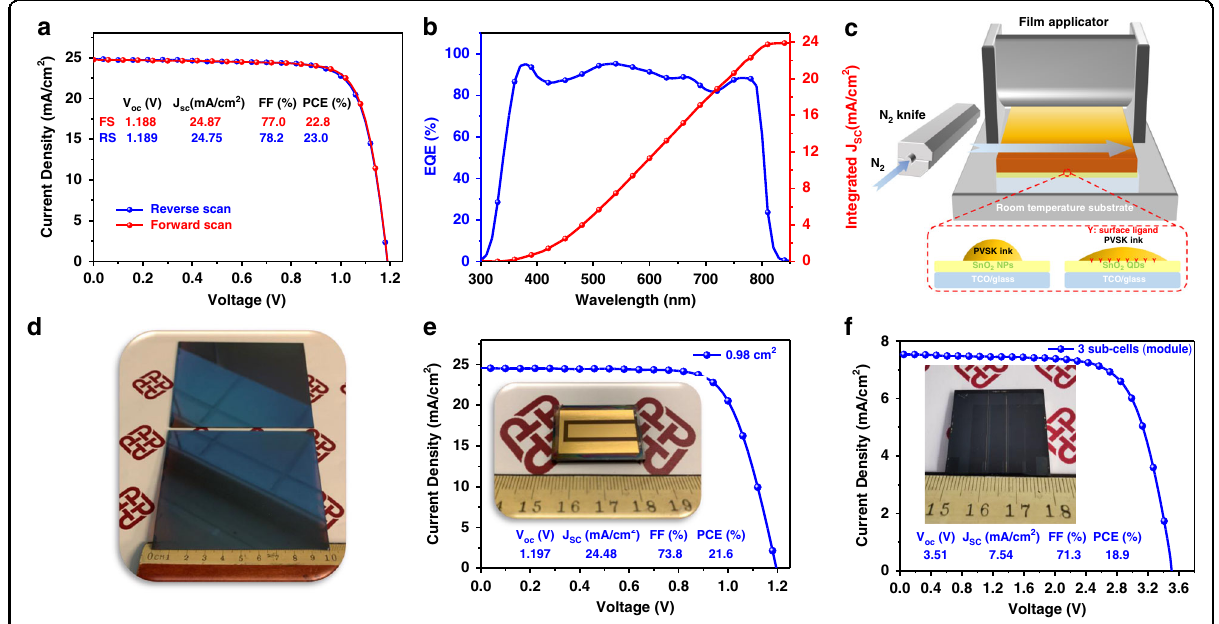
Fig. 6 Best cell and mini-module performance of blade-coated devices. a J – V curves, b EQE spectra, and integrated current density of the best SnO 2 QDs-based perovskite solar cell with a bandgap of 1.541 eV. c Schematic illustration of air-knife-assisted blade-coating at room temperature. d Digital image of the blade-coated large area (90 mm × 100 mm) perovskite fi lm on SnO 2 QDs-coated substates. e J – V curves of the best performance blade-coated devices with SnO 2 QDs. Inset: a digital image representing a 20 × 30 mm 2 substrate (active area: 0.98 cm 2 ) by meniscus blade-coating. f J – V curves of a champion module with a 1.613 eV perovskite system. Inset: a digital image representing a 30 × 30 mm 2 substrate with three sub-cells (a total active area of 2.7 cm 2